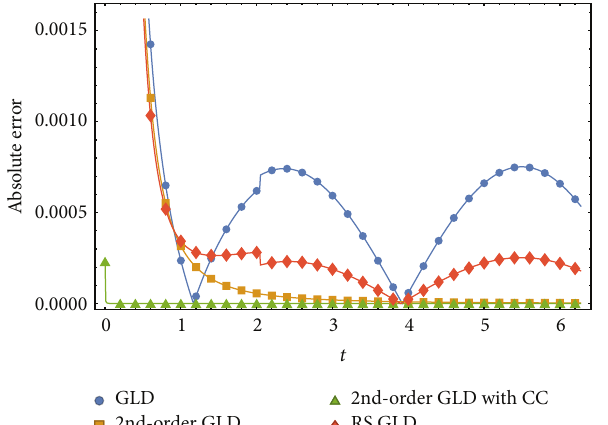
Figure 8: Absolute error over varying values of 𝛼 for four different methods.